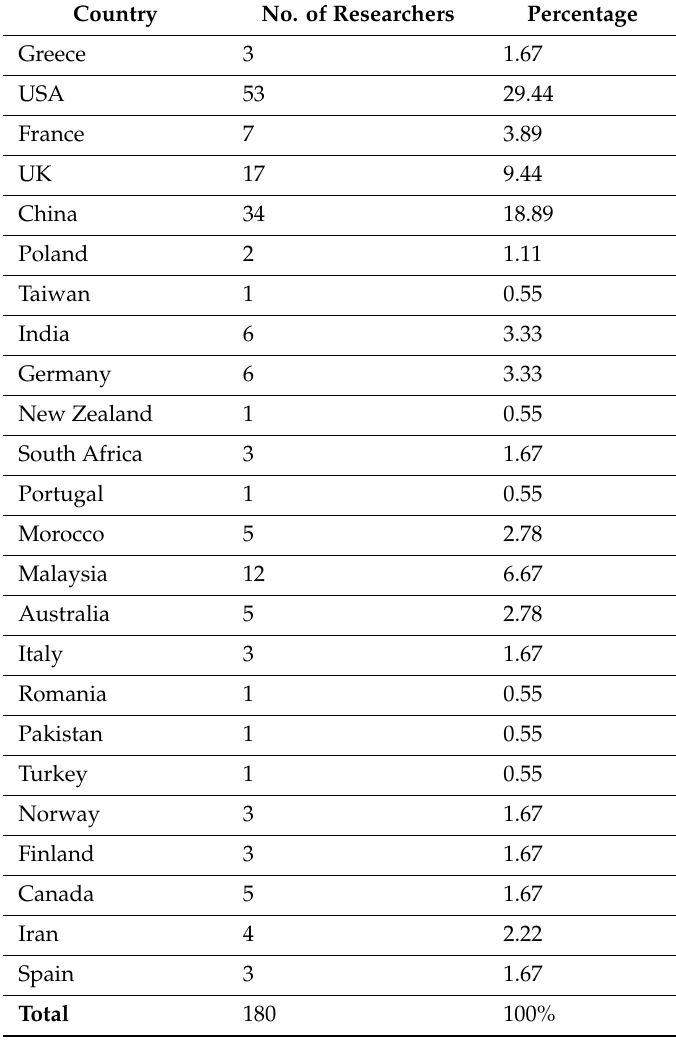
Table 4. Number of researchers by country.